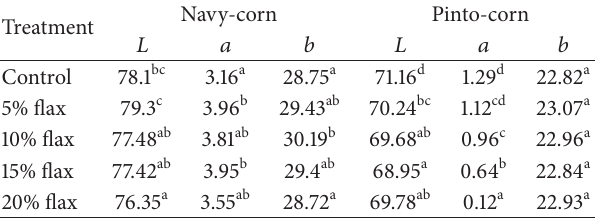
Table 1: Mean color values of navy-corn and pinto-corn extrudates. Treatment